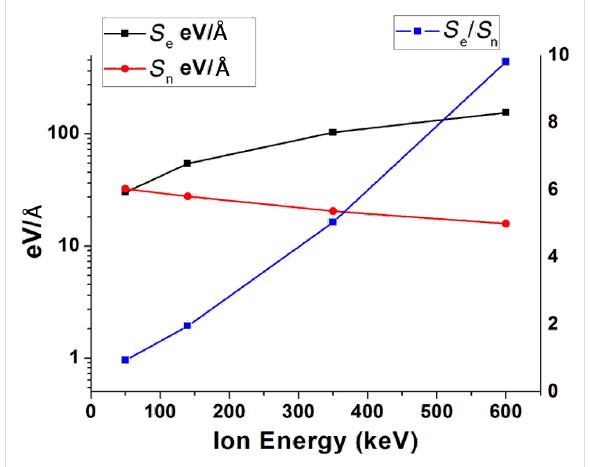
Figure 1: Electronic and nuclear stopping vs ion energy (SRIM calcu- lation for neon ions incident on Pt).